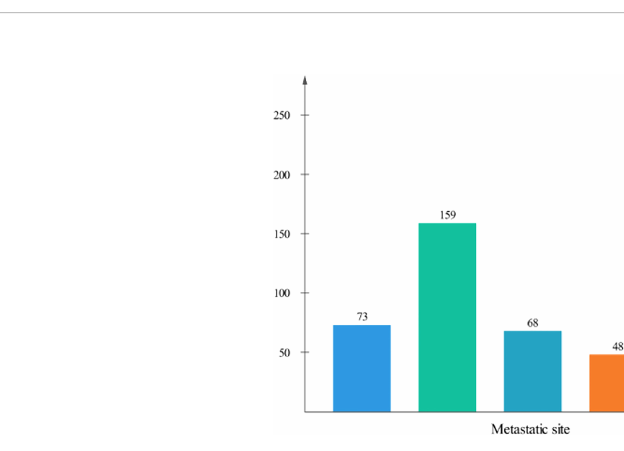
FIGURE 2 Number of patients with different metastatic patterns in LCNEC.